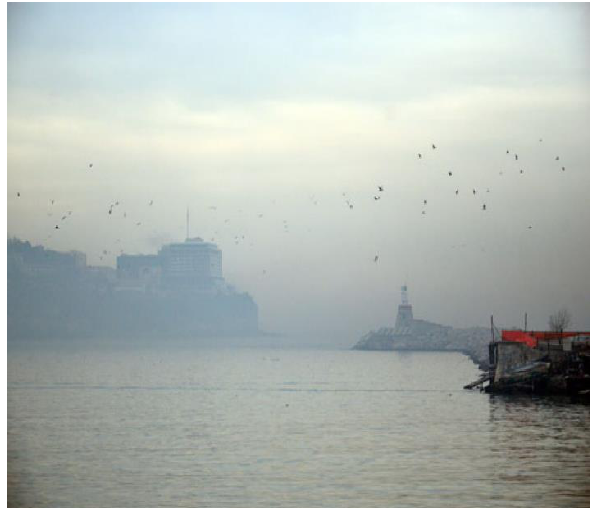
Figure 1. Low visibility range in Zonguldak (PM 10 = 191 µg/m 3 ).